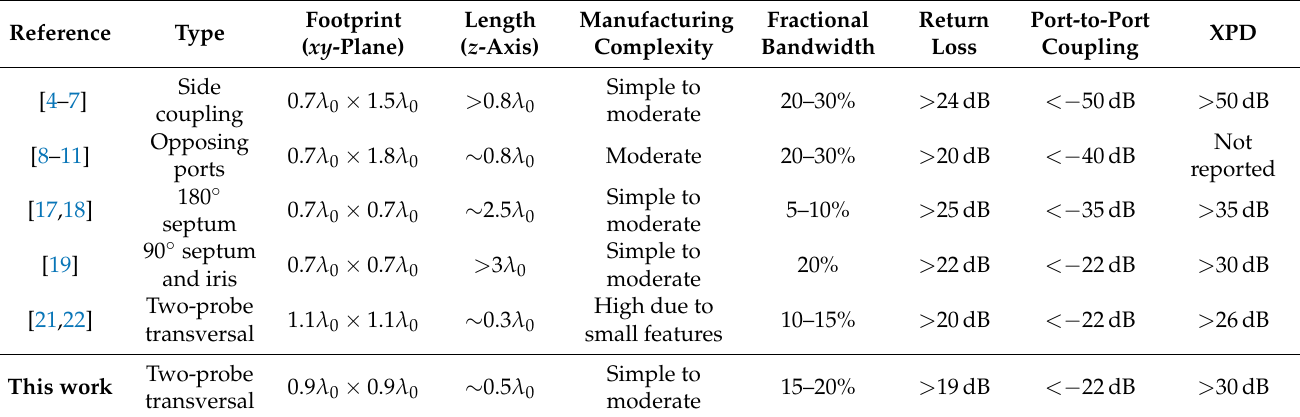
Table 3. Comparison with existing compact two-probe waveguide